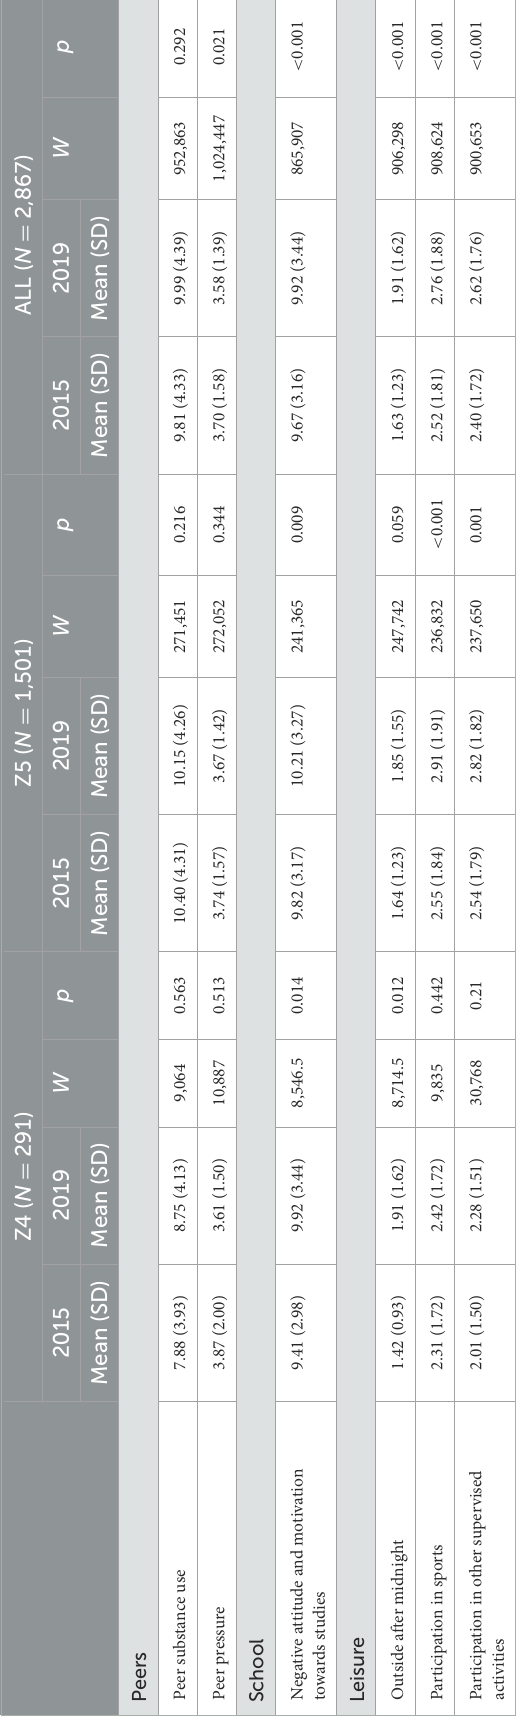
Table 3 contains the logistic regression results from both the main-effects model and the main-effects model with time added as an interaction. Results are presented as odds with accompanying 95% confidence